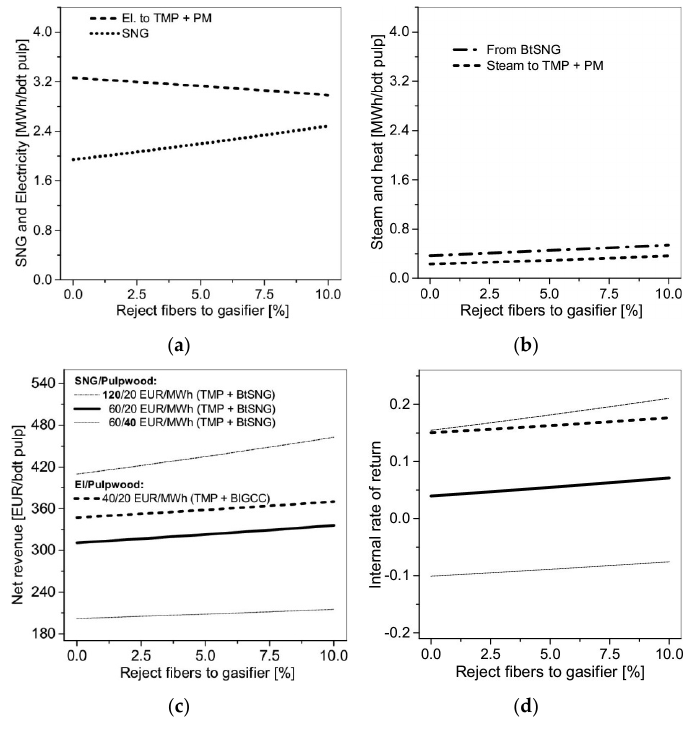
Figure 7. Effect of adding reject fibres.